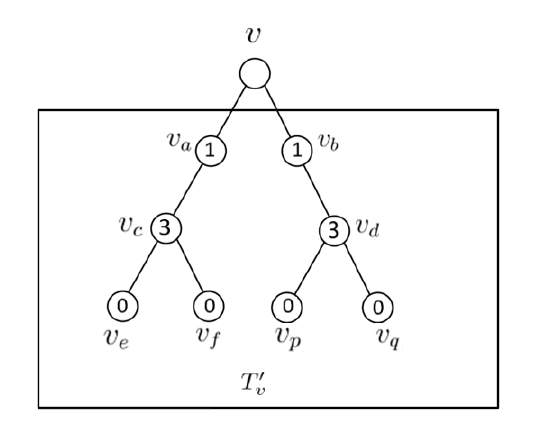
Figure 2. Pre-labeling of g